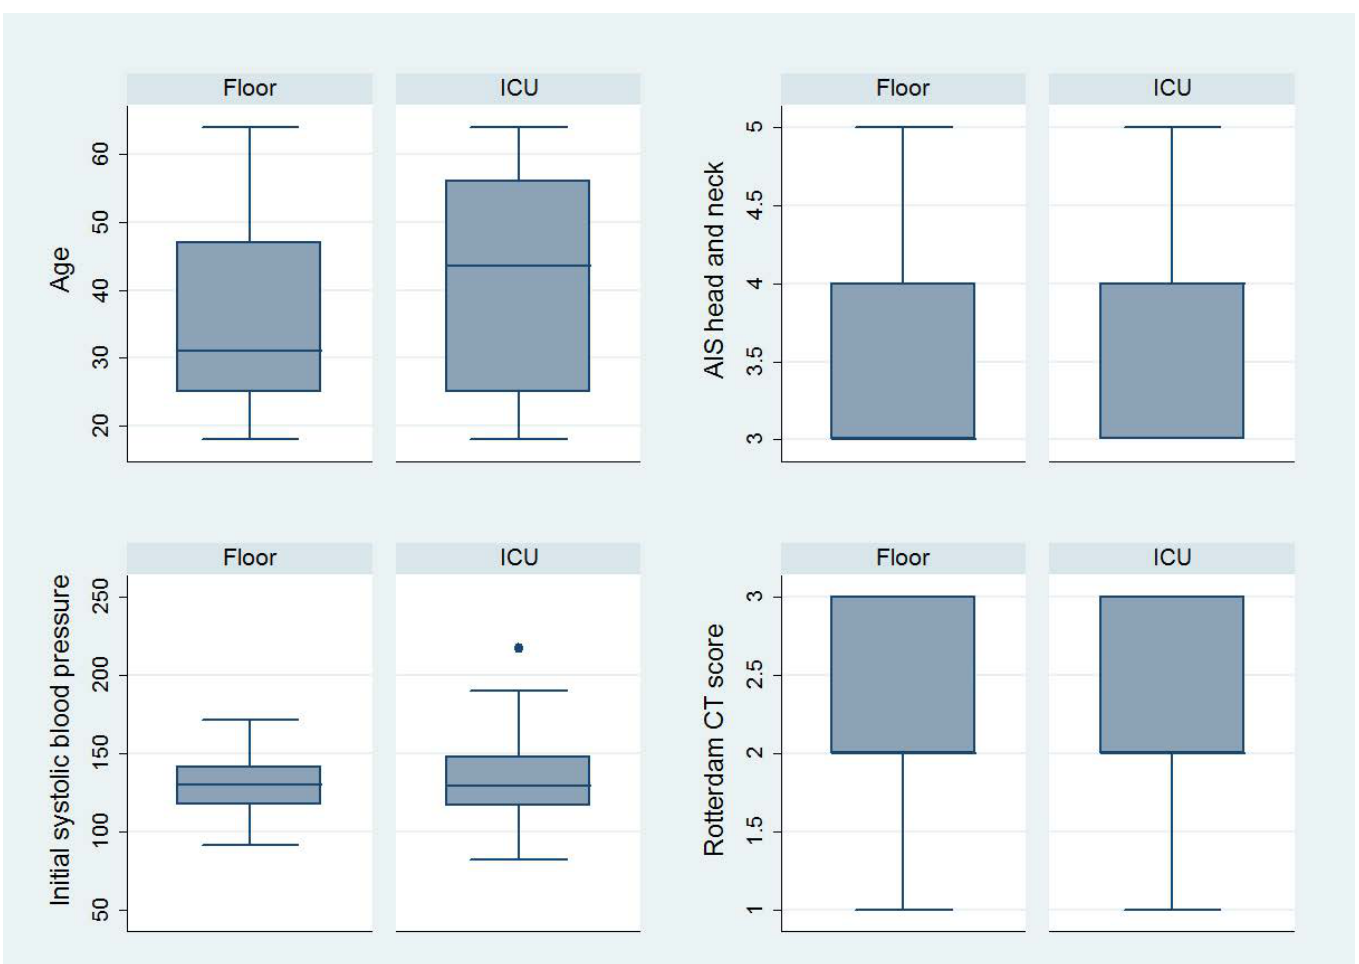
Figure 2. Distribution of independent variables by admission location.